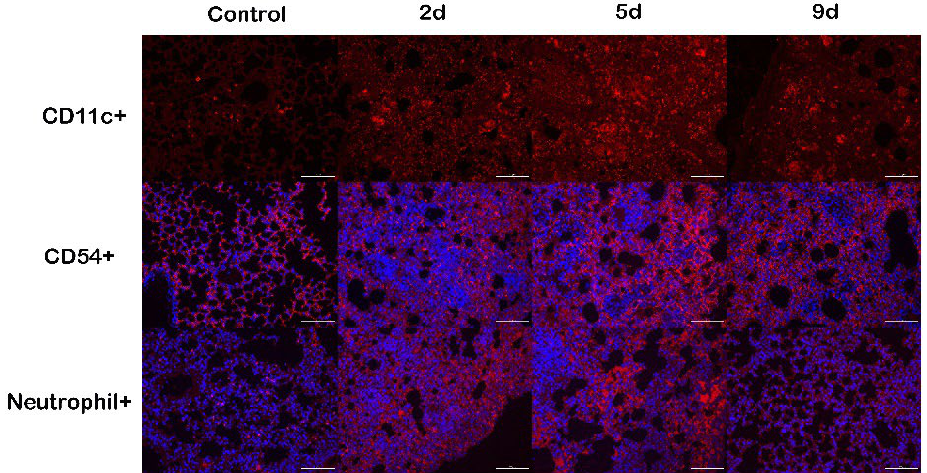
Figure 8. Immune cells were recruited in the lungs of mice infected with M. gypseum (4 × 10 6 CFU/mL) on days 2, 5, and 9 after infection. Immunofluorescence staining revealed that polymorphonuclear neutrophils (PMNs), dendritic cells (CD11c, CD11c+), and macrophages (CD54, CD54+) were recruited mainly around the alveolar septum (red fluorescence increased). Scale bars, 100 μm.